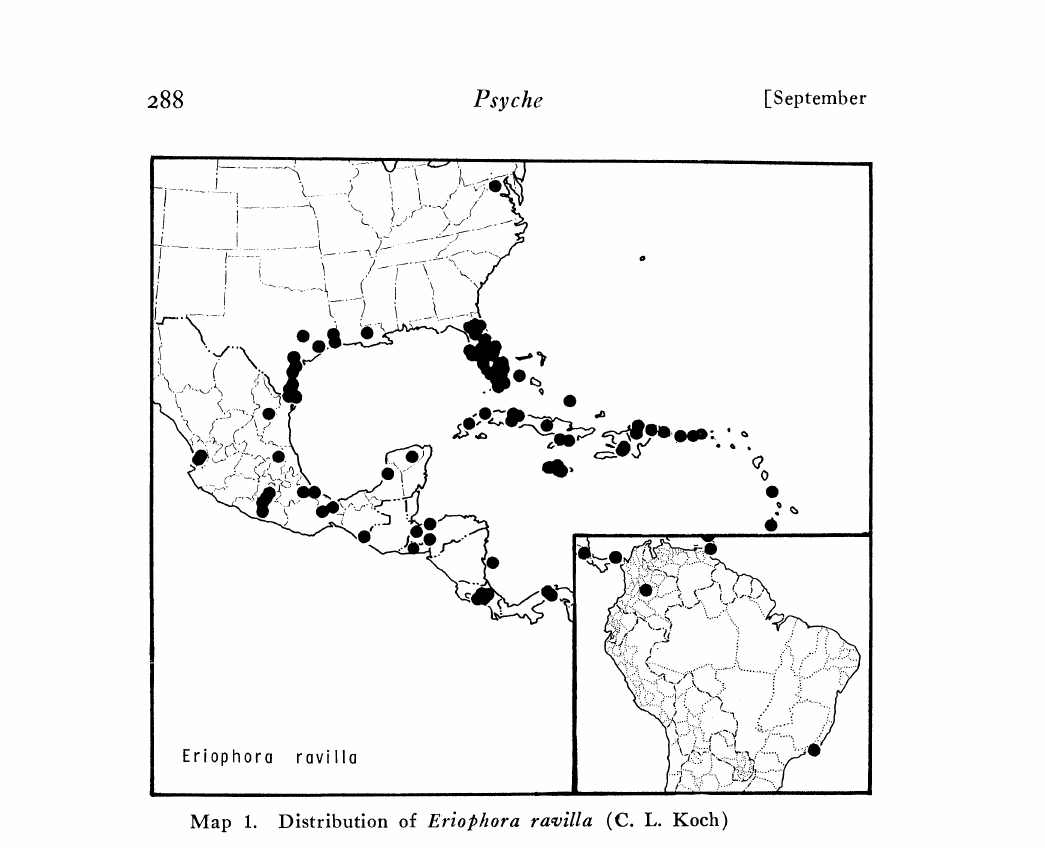
Map 1. Distribution of Eriophora rac:illa (C. L.